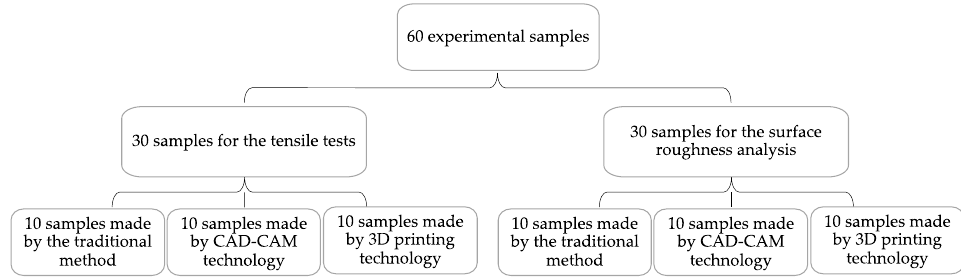
Figure 1. Experimental samples. CAD: Computer-aided design; CAM computer-aided manufac- turing